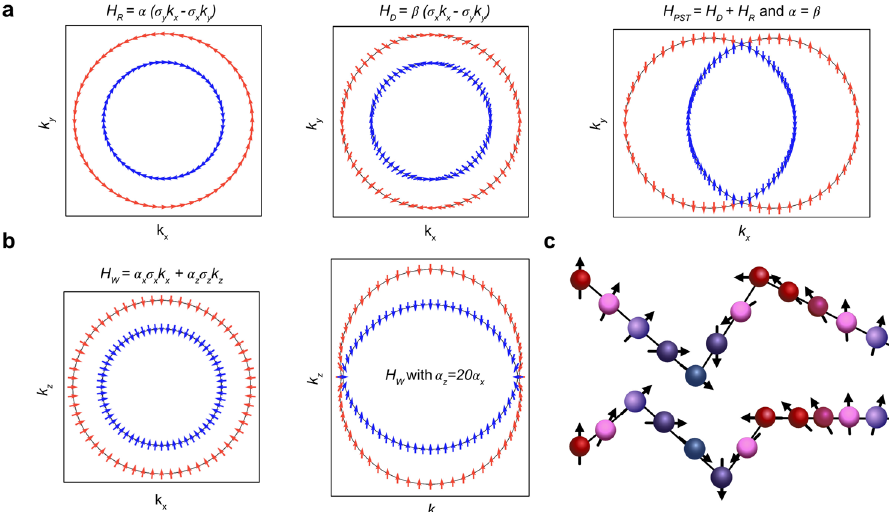
Fig. 5 Persistent spin texture and spin helix in the Rashba – Dresselhaus (RD) and Weyl (W) models enhancing spin transport in systems with strong SOC. a Pure Rashba (left) and Dresselhaus (middle) models; their combination with α = β (right) generates a persistent spin texture in the momentum space. b Analogous mechanism contributing to a persistent spin texture in the Weyl model describing the radial spin texture; Weyl Hamiltonian with equal ( α z = α x ) parameters (left) and with the prevailing α z σ z term (right). The latter, with α z = 20 α x closely resembles the spin texture of Te (see Fig. 2a). c Schematic illustration of a persistent spin helix in the real space observed in quantum wells with balanced Rashba and Dresselhaus terms 58 . The collective spin is a conserved quantity due to the emergence of the SU (2) symmetry. The quasi-persistent spin texture described by the Weyl Hamiltonian will lead to a similar effect protecting the spin